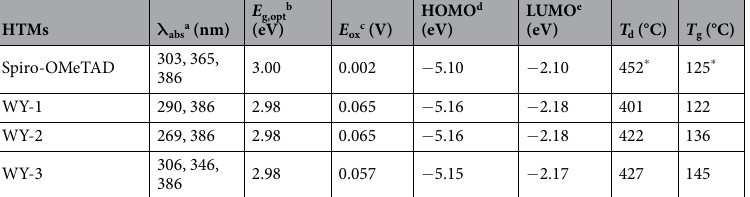
Table 1. Electrochemical, photophysical and thermal properties of Spiro-OMeTAD, WY-1, WY-2, and WY-3. a Measured in THF with a concentration of 10 − 5 M. b Calculated from the absorption onset. c The oxidative onsets (vs FcH/FcH + ) measured by cyclic voltammetry in CH 2 Cl 2 . d HOMO = − ( E ox + 5.1) eV and LUMO = HOMO + E g,opt .